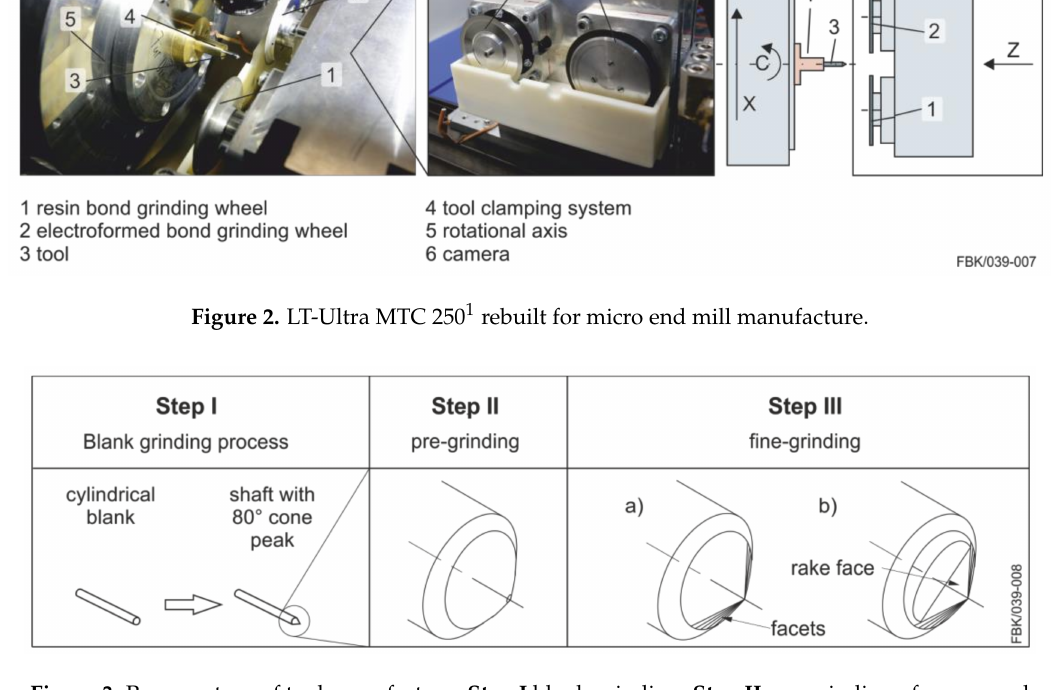
Figure 3. Process steps of tool manufacture. Step I blank grinding. Step II pre-grinding of a cone and Step III fine-grinding with ( a ) grinding of the facets ( b ) grinding the rake